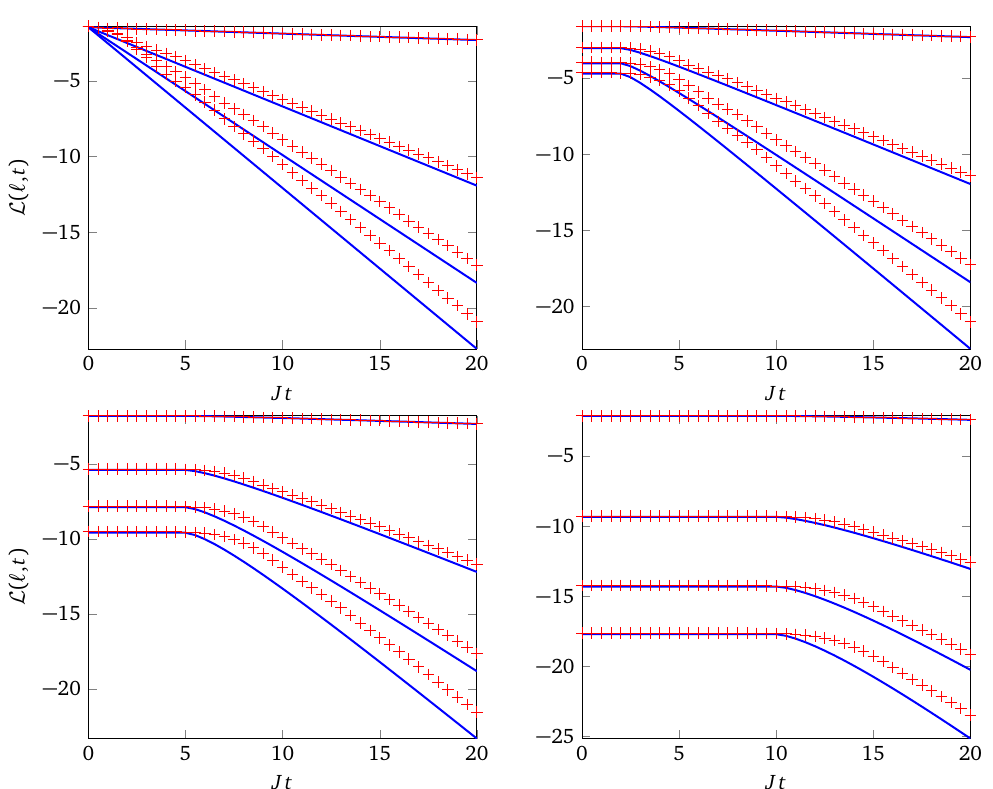
Figure 12: L ( (cid:96) , t ) as a function of t for h = 0.5 and β = 2,0.5,0.286,0.2 from top to bottom inside each panel, with (cid:96) = 0,2,5,10 from top left to bottom right. Numerical results for a L = 200 site open chain are shown by red crosses and equation (143) by a straight blue line. The slopes of the numerical results are correctly reproduced t > (cid:96) . by (143) in the time-like region, i.e. for v max